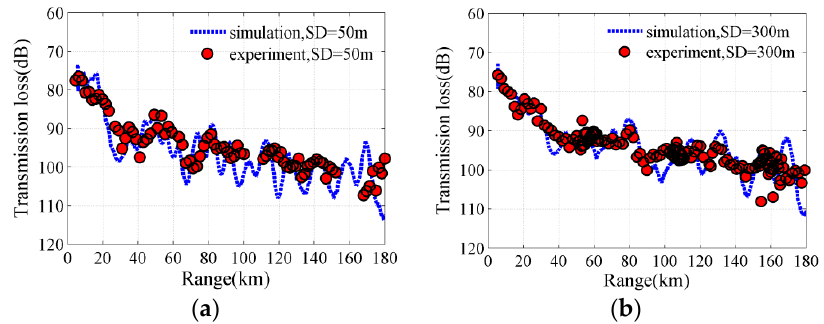
Figure 9. Transmission losses comparison between simulation and experiment at 100 Hz for source depths of ( a ) 50 m and ( b ) 300 m. Table 1. Sediment and basement acoustic parameters.